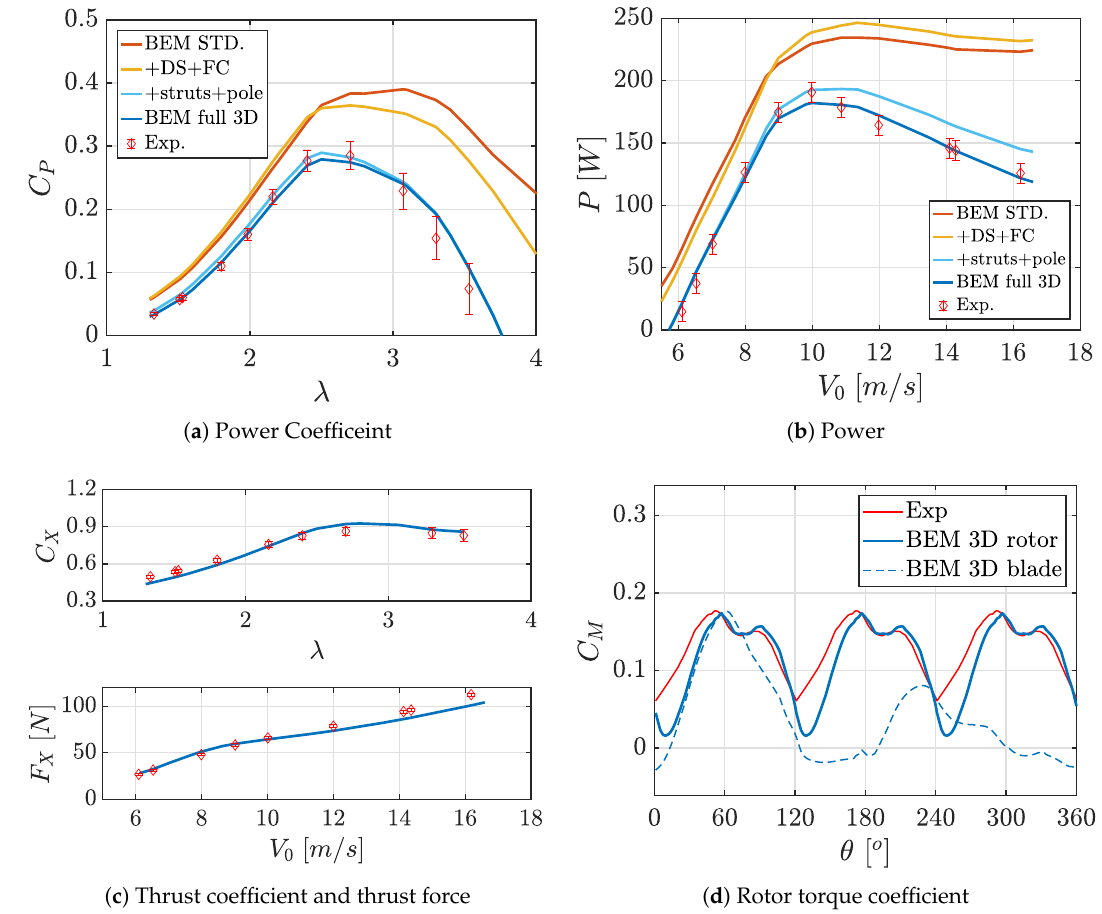
Figure 5. Comparison of experimental and 3D BEM results for the H-shaped 200 W